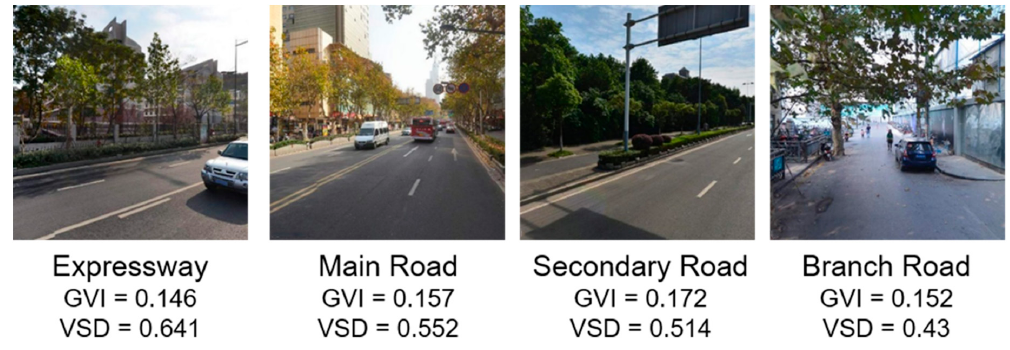
Figure 15. GVI and VSD distributions of different road levels in box plots. ( a ) Box plots of GVI distribution. ( b ) Box plots of VSD distribution.